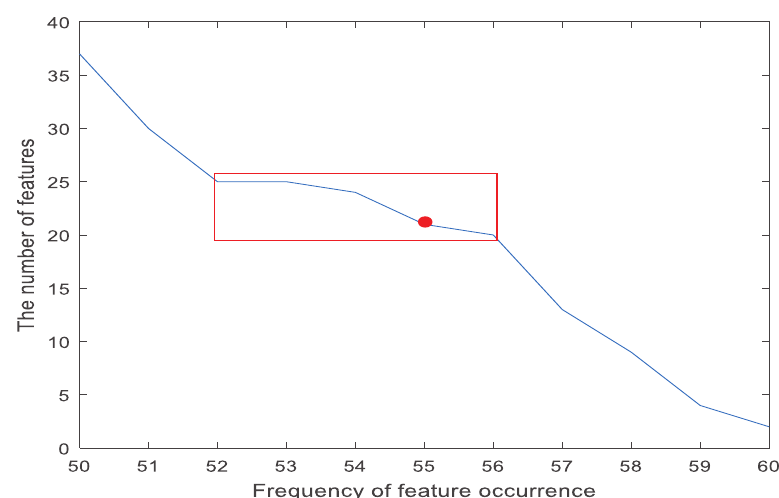
Figure A8. The characteristic frequency distribution with a frequency greater than or equal to 50. The x axis corresponds to the frequency of occurrence, and the y axis is the number of features. We can find that when the frequency is in the red range, i.e., greater than or equal to 52 and less than or equal to 56, the number of features is quite stable. Compared with other ranges, in the red range, there exists a balance between the number of features and the frequency of occurrence, which facilitates the abnormal analysis of brain function connections and structures corresponding to diseases. Therefore, we selected features with a frequency greater than or equal to